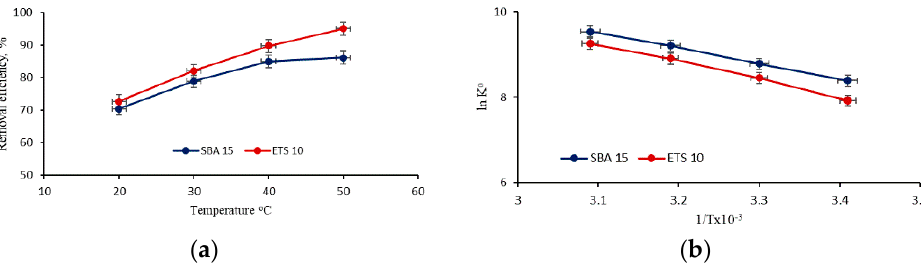
Figure 5. Temperature dependence ( a ) of removal efficiency of Cu(II) onto SBA-15 and ETS-10 sorbents and plot for the evaluation of the thermodynamic parameters ( b ). Table 4. Thermodynamic parameters of the sorption process.